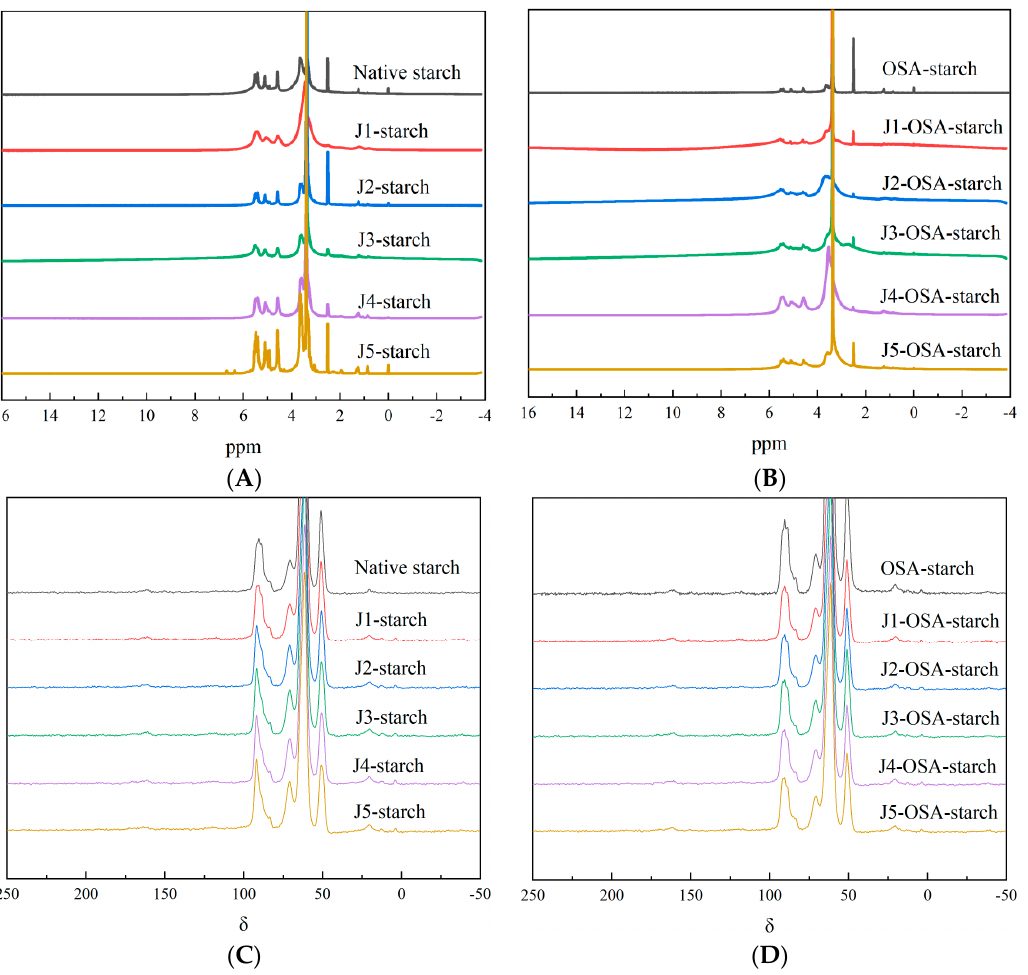
Figure 5. 1 H-NMR and 13 C-NMR spectra of J-starch and J-OSA-starch : ( A ), 1 H-NMR spectra of J-starch; ( B ), 1 H-NMR spectra of J-OSA-starch; ( C ), 13 C-NMR spectra of J-starch; ( D ), 13 C-NMR spectra of J-OSA-starch.